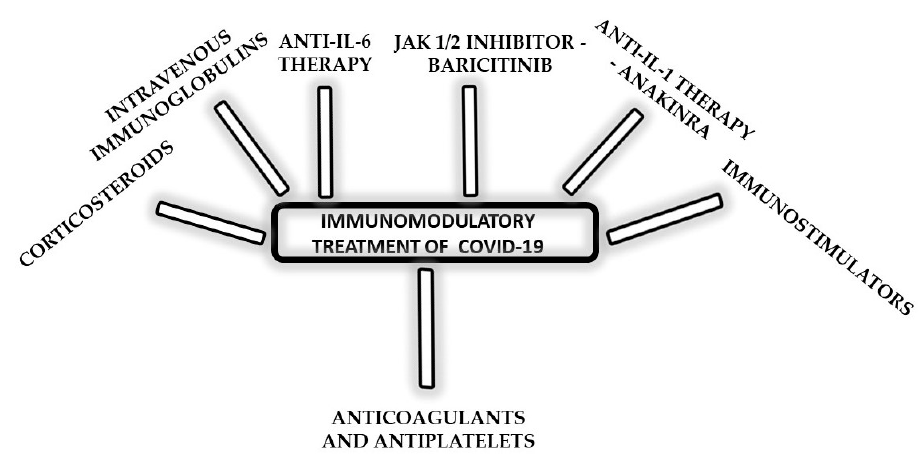
Figure 2. Key elements of the immunomodulatory treatment of COVID-19.